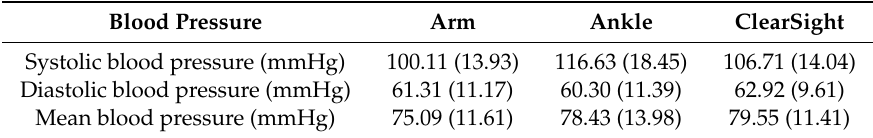
Table 2. Mean and standard deviation values of systolic, mean and diastolic blood pressure (mmHg) measured by the three di ff erent